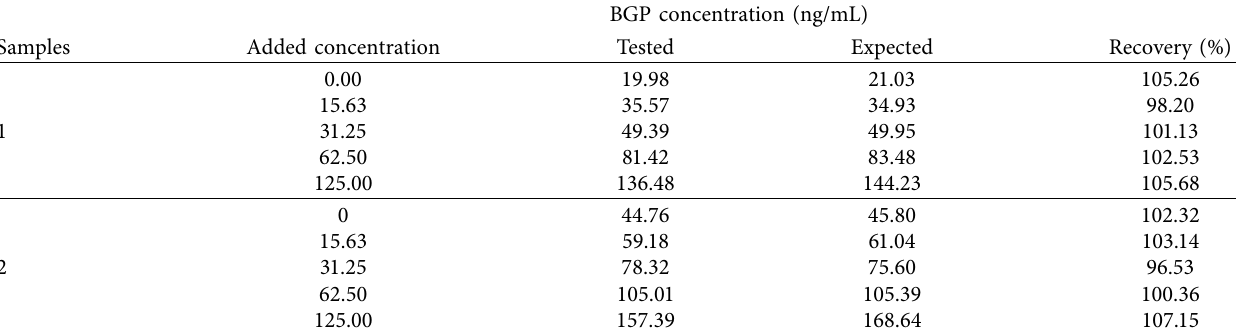
Table 4: Analytical recovery.